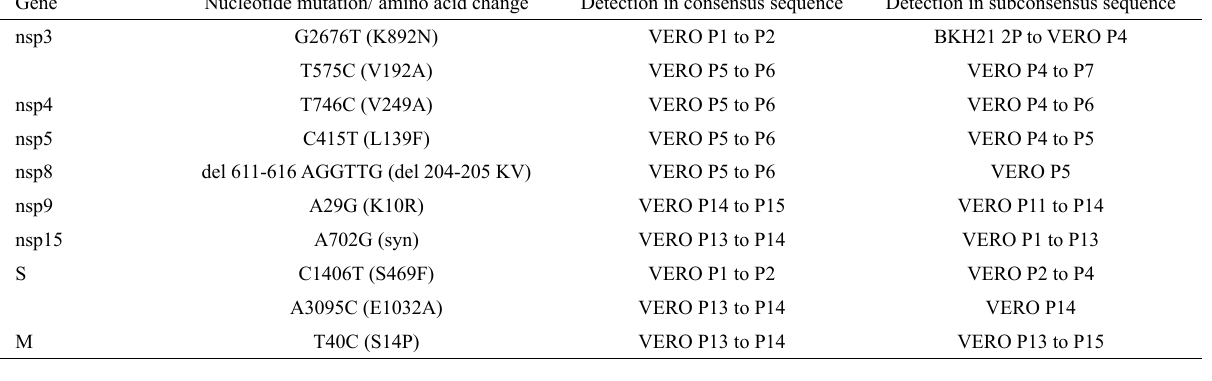
Table 2 – Nucleotide mutations and amino acids changes detected after passages of the Beaudette strain of AvCoV in BHK-21 and VERO cells, showing the passage (P) they were detected at in both the consensus and the consensus levels; syn=synonymous mutation. Gene Nucleotide mutation/ amino acid change Detection in consensus